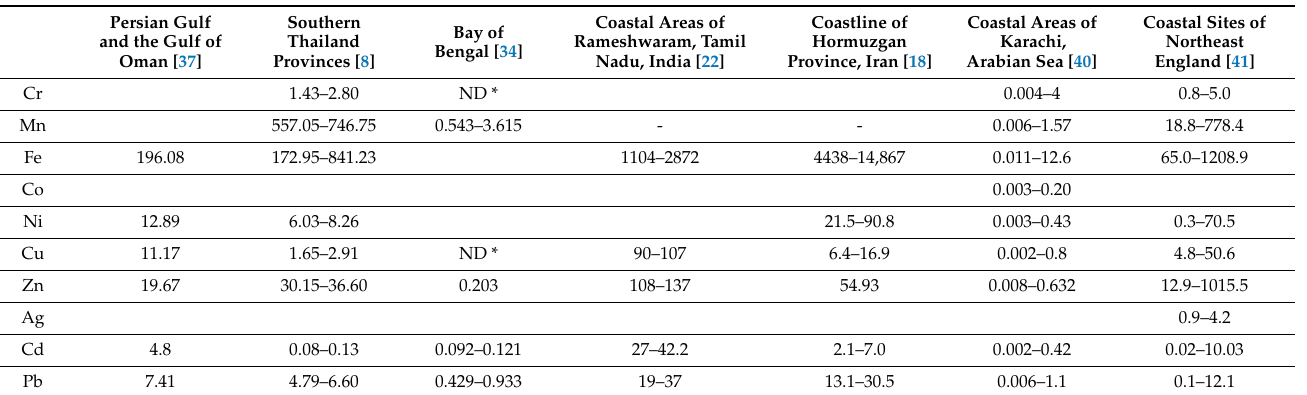
Table 2. Concentration of the heavy metals in seaweed species at different geographical locations measured by AAS. All values are in µ g/g dry weight. The following data show the range of minimum and maximum values where